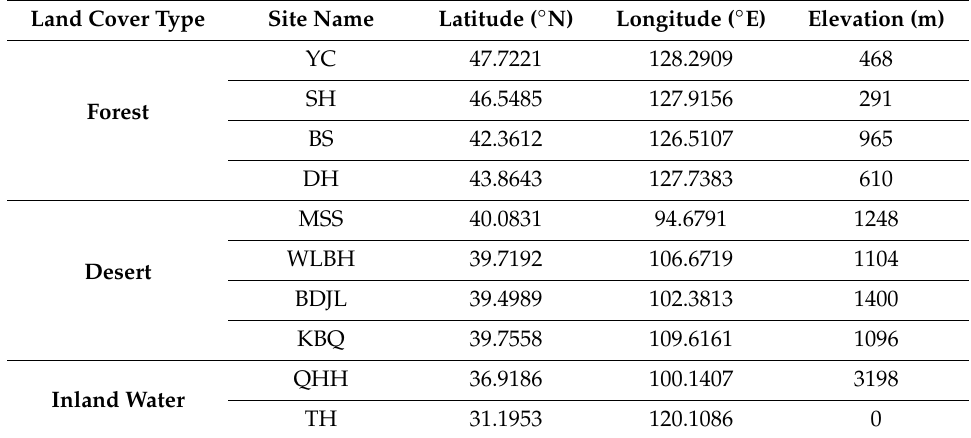
Table 6. Information on the R-based